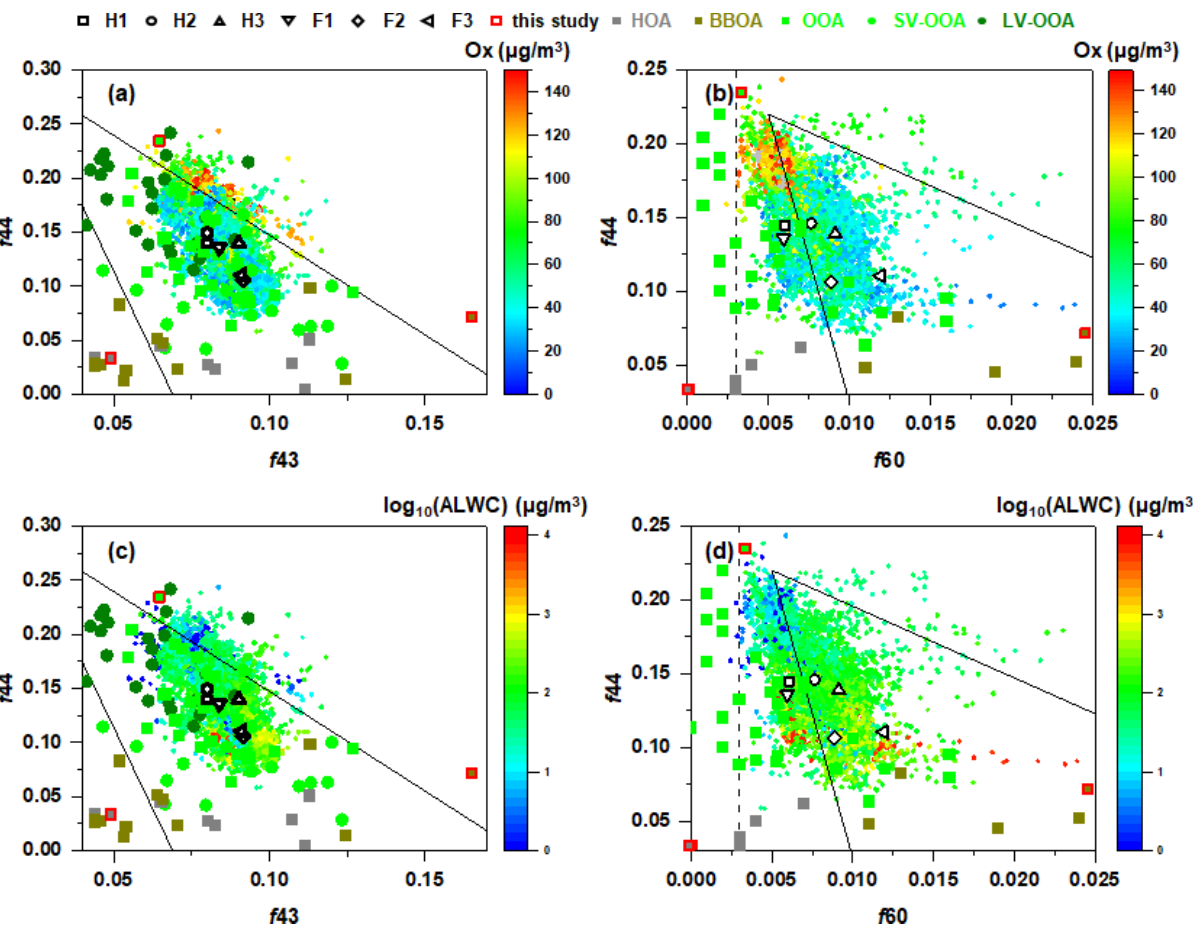
Figure 7. Triangle plots of (a, c) f 44 (ratio of m/z 44 to total signal in the component mass spectrum) vs. f 43 (ratio of m/z 43 to total signal in the component mass spectrum) and (b, d) f 44 vs. f 60 (ratio of m/z 60 to total signal in the component mass spectrum) during the whole campaign. The colour scale in (a) and (b) represents O x concentration, and that in (c) and (d) represents log 10 (ALWC). The solid lines in (a) and (c) are derived from the results reported by Ng et al. (2010). The dashed line representing the background value of secondary aged OA and the solid guidelines in (b) and (d) are derived from Cubison et al. (2011). The f 44 vs. f 43 and f 44 vs. f 60 for different OA sources reported in previous studies are also shown (Kim et al., 2019; Ng et al., 2011a; Wang et al., 2016; Zhao et al., 2019; Paglione et al.,